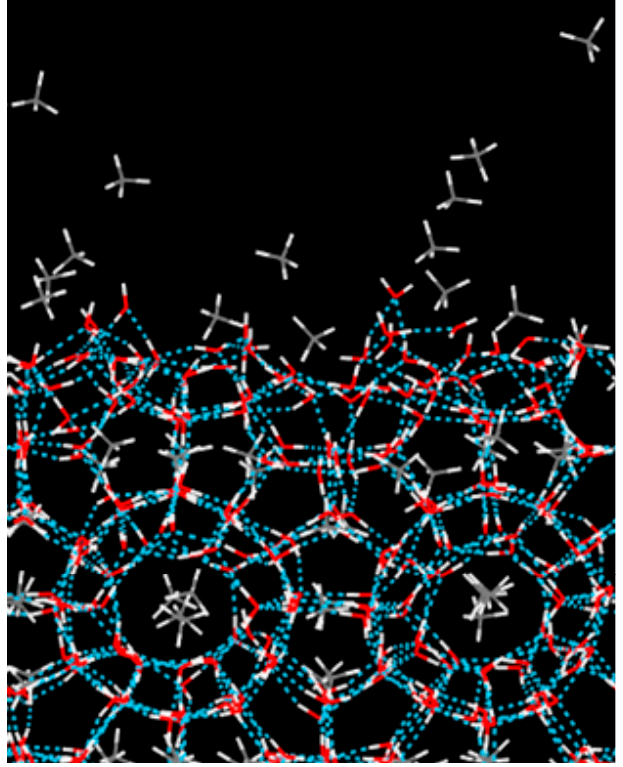
Figure 2. The diffusion of methane molecules from partially filled cages and partial cages distortion.